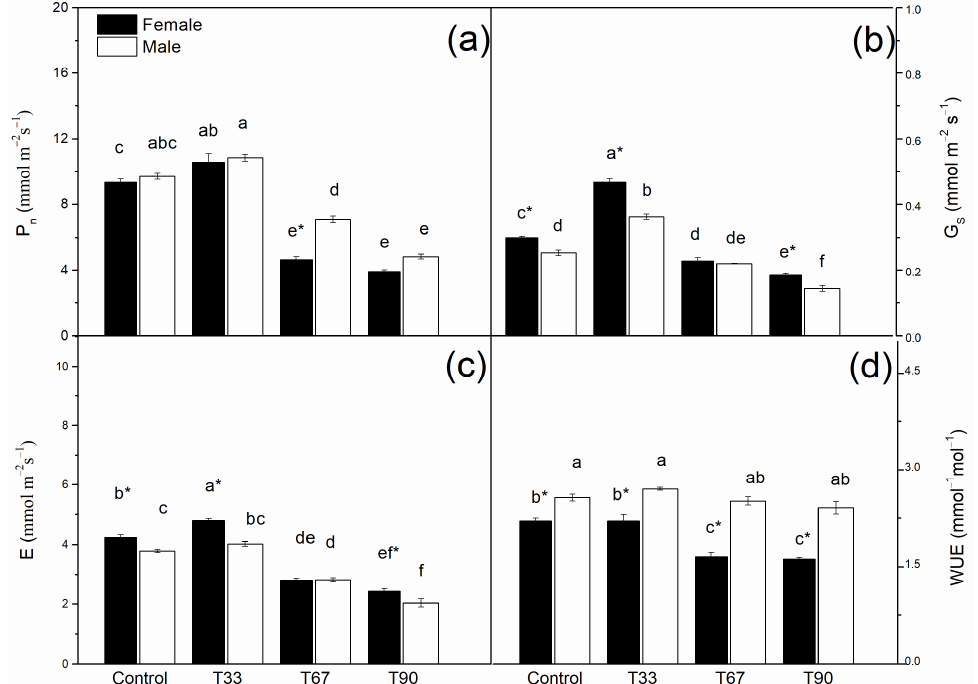
Figure 1. Mean values ( ± SE, n = 5) of photosynthetic parameters in the leaves of females and males of H. rhamnoides under different sand burial depths: ( a ) P n , net photosynthetic rate; ( b ) G s , stomatal conductance; ( c ) E, transpiration rate; ( d ) WUE, water-use efficiency. Different lowercase letters indicate significant differences between sexes and sand burial treatments according to Bonferroni’s tests ( p < 0.05). * indicates significant differences between female and male saplings at the same treatment depth ( p < 0.05). Control, unburied treatment; T33, T67 and T90 correspond to sand burial depths of 33, 67 and 90 percent of the original plant height, respectively. Table 2. Statistical significance of single and interactive effects of sex and sand burial depth on physiological parameters of H. rhamnoides saplings based on two-way ANOVA. Variable